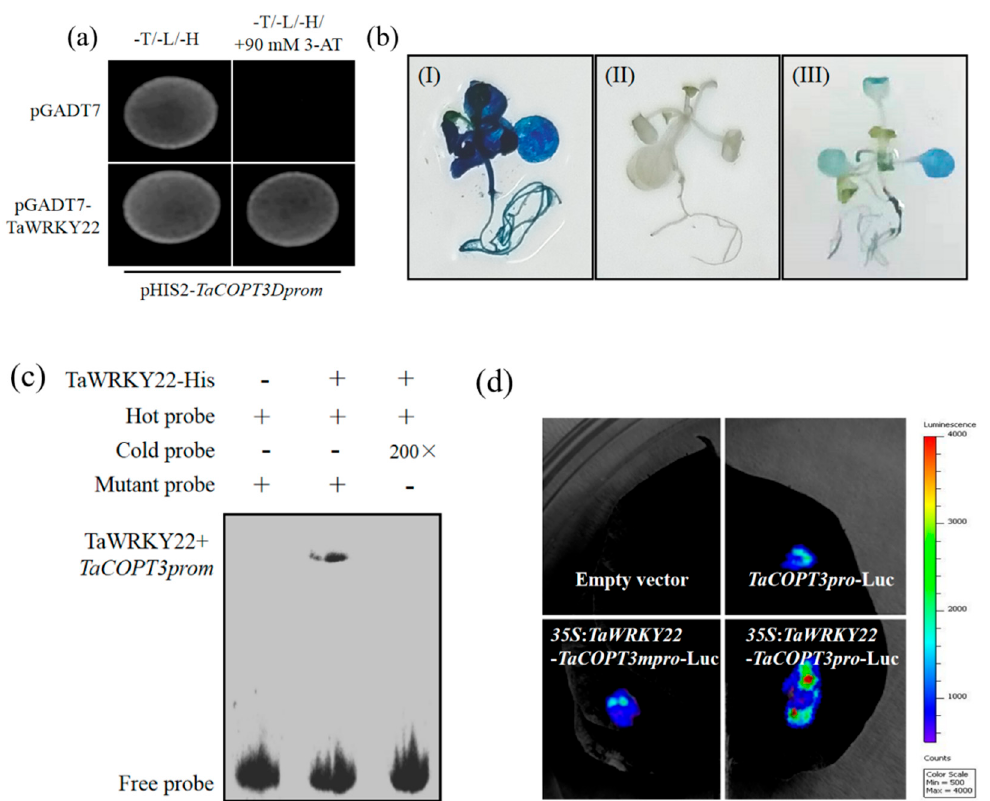
Figure 6. ( a ) Yeast one-hybrid assays; ( b ) Identification of TaWRKY22 binds to W-box of TaCOPT3D promoter. (I): Arabidopsis expression of TaCOPT3D -GUS; (II): Arabidopsis expression of TaWRKY22 ; (III): Arabidopsis co-expression of TaCOPT3D -GUS and TaWRKY22 ; ( c ) EMSA assay showing that TaWRKY22 fusion protein directly bound to the TaCOPT3D promoter in vitro ; ( d ) Transient expres- sion assays showing that TaWRKY22 regulates the expression of TaCOPT3D .